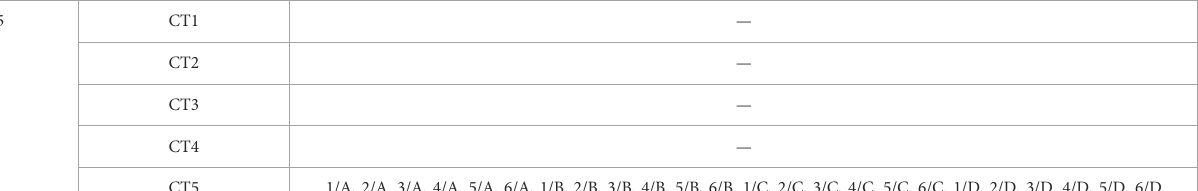
bricks, and a 50 mm thick upper RC slab. Both for the elevation and foundation structures, reinforcing bars are made of FeB44k steel, with yield stress and tensile strength values greater than 430 MPa and 540 MPa, respectively; and concrete is 25/30 class, with cylindrical and cubic compressive strength of 25 MPa and 30 MPa, respectively. The dead and live loads assumed in the analyses are as follows: 5 kN/m 2 (dead) and 2 kN/m 2 (live) on fi rst through fi fth fl oor; 3.8 kN/m 2 and 1.2 kN/m 2 on sixth (roof) fl oor. The live loads on the stairwell are equal to 4 kN/m 2 . A view of the fi nite element model of the structure, generated by SAP2000NL software (CSI, 2022), is displayed in Figure 4, where the Cartesian reference system is traced out too. Elastic frame elements